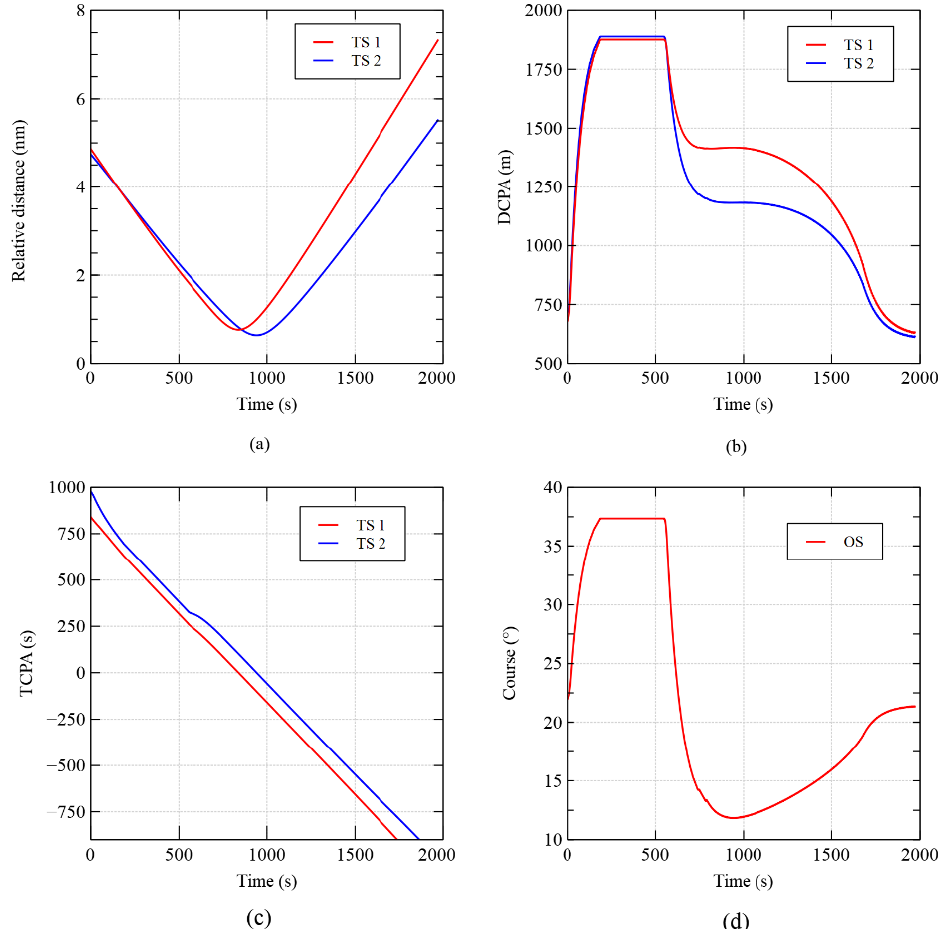
Figure 11. Real-time parameter changes under three-ship encounter situation. ( a ) Relative distance between OS and TSs; ( b ) DCPA between OS and TSs; ( c ) TCPA between OS and TSs; ( d ) the course of OS.